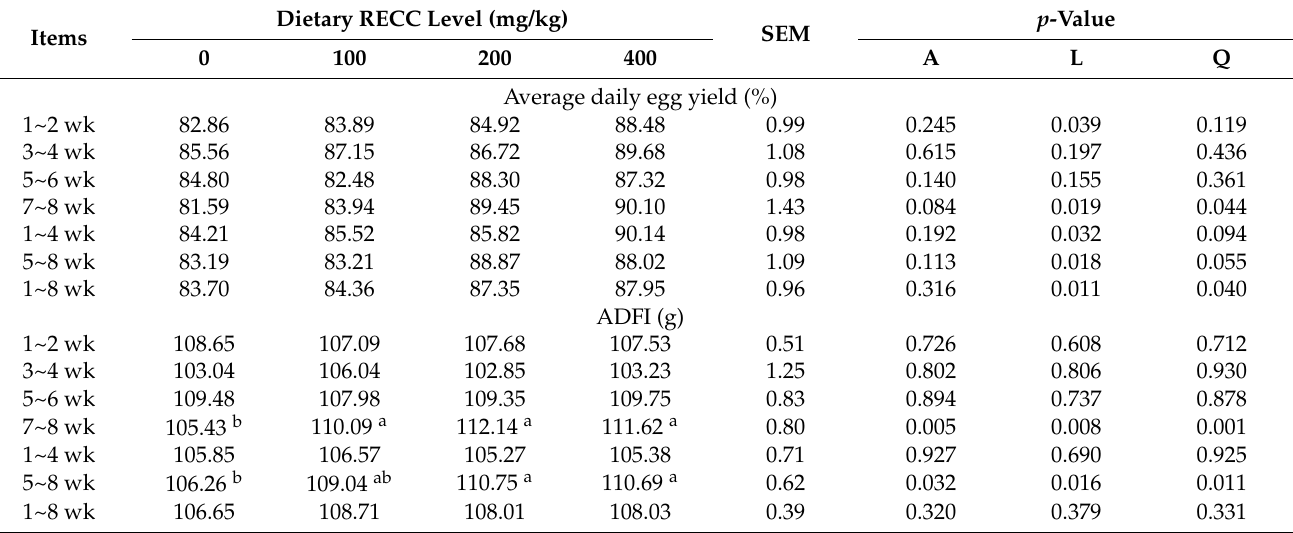
Table 2. Effects of dietary rare earth chitosan chelates (RECC) on the performance of laying